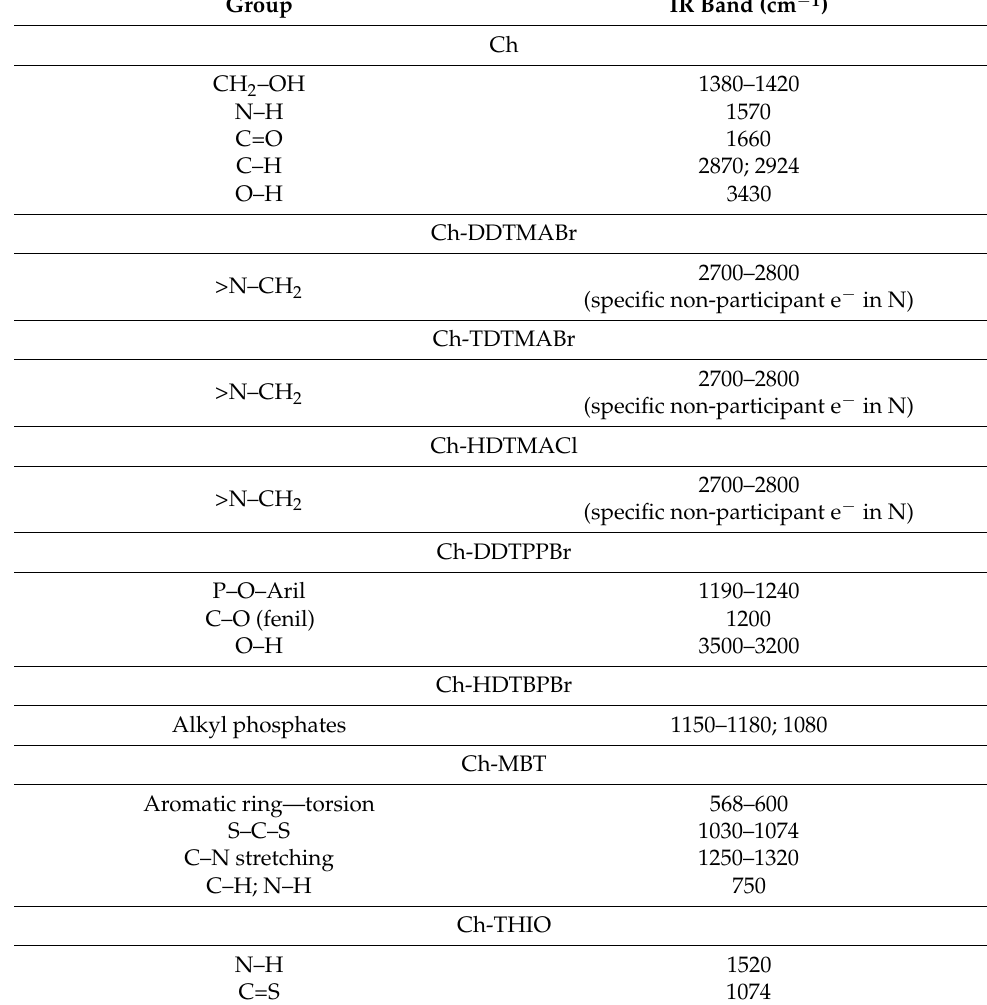
Figure 3. (a-h) FT-IR spectra for materials obtained by functionalizing chitosan with different extractants. Table 1. Specific IR bands specific to the groups in Ch and extractants.